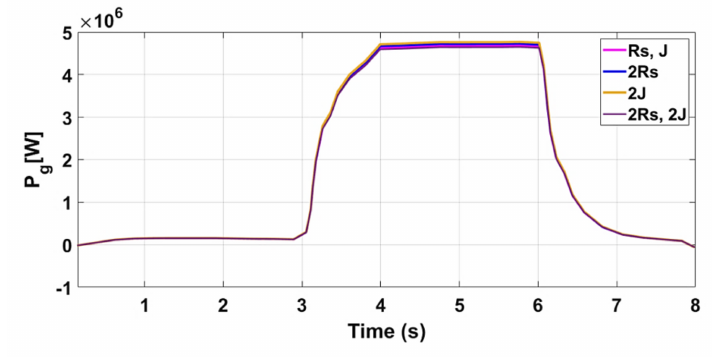
Figure 16. Active power with parameter